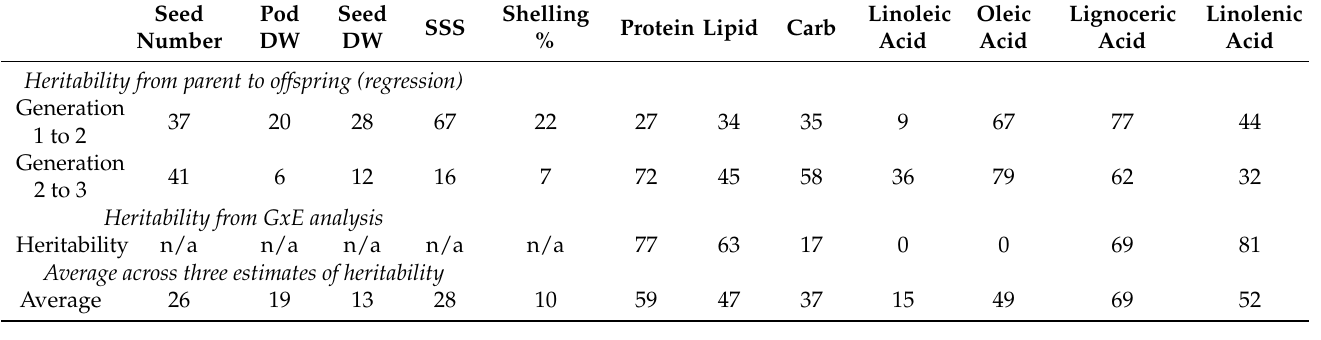
Table 6. Estimation of heritability using two methods: parent–offspring regression analysis and GxE analysis using two subsets of bambara groundnut lines as described in heritability analysis (Section 2.4) Input data for nutritional traits were mean values calculated from technical triplicate analysis, expressed in g/100 g seed dry weight (Supplementary Table S3). Input data for agronomic traits were mean values for the bambara groundnut line calculated from all replicates for the line